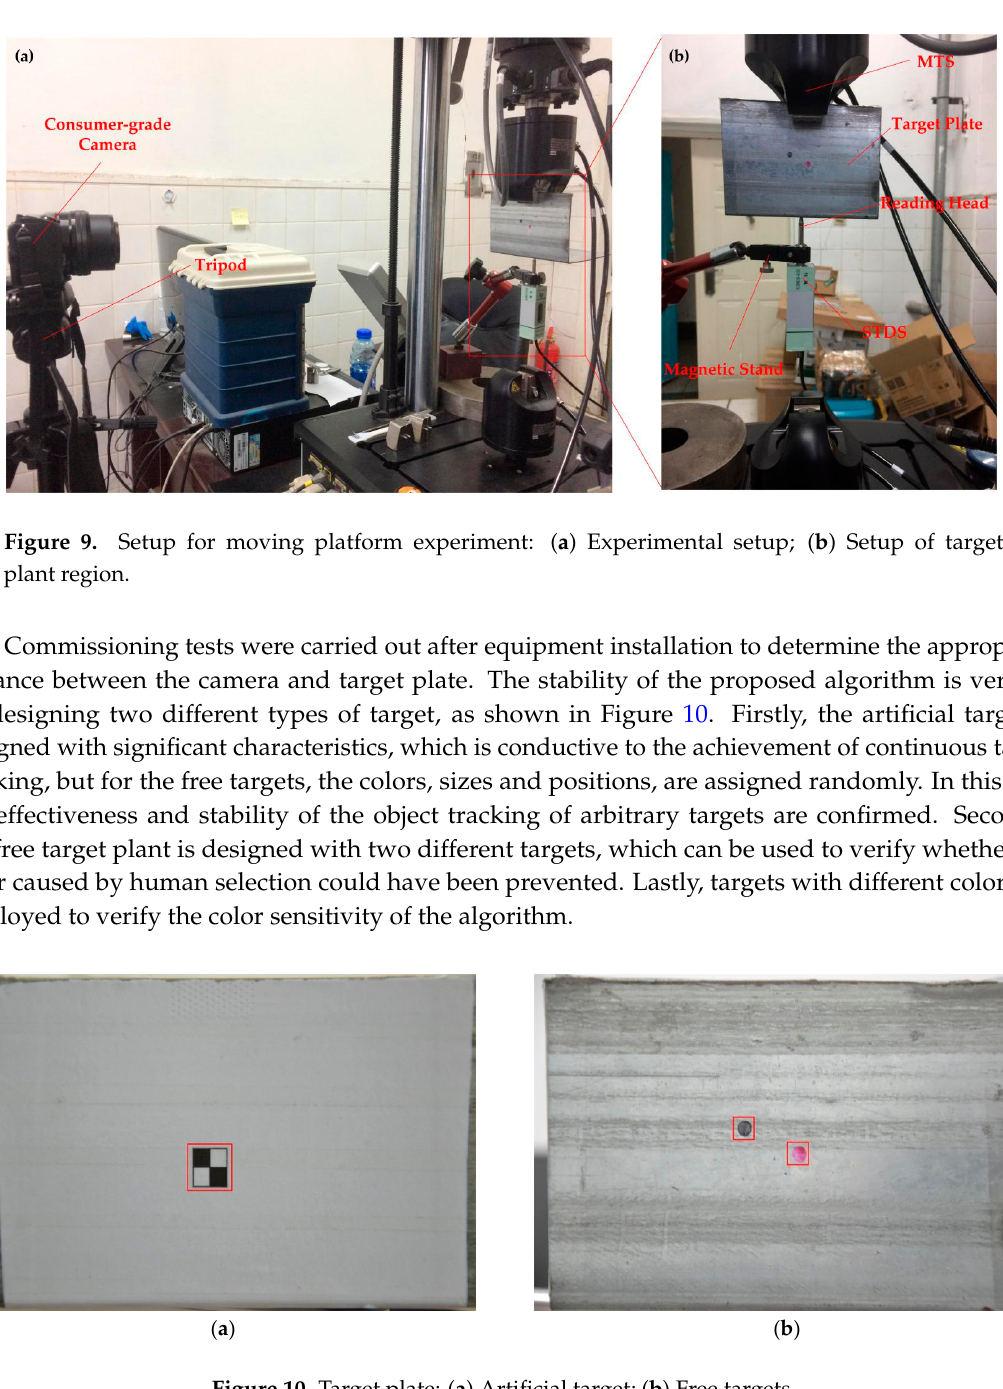
Figure 10. Target plate: ( a ) Artificial target; ( b ) Free targets.